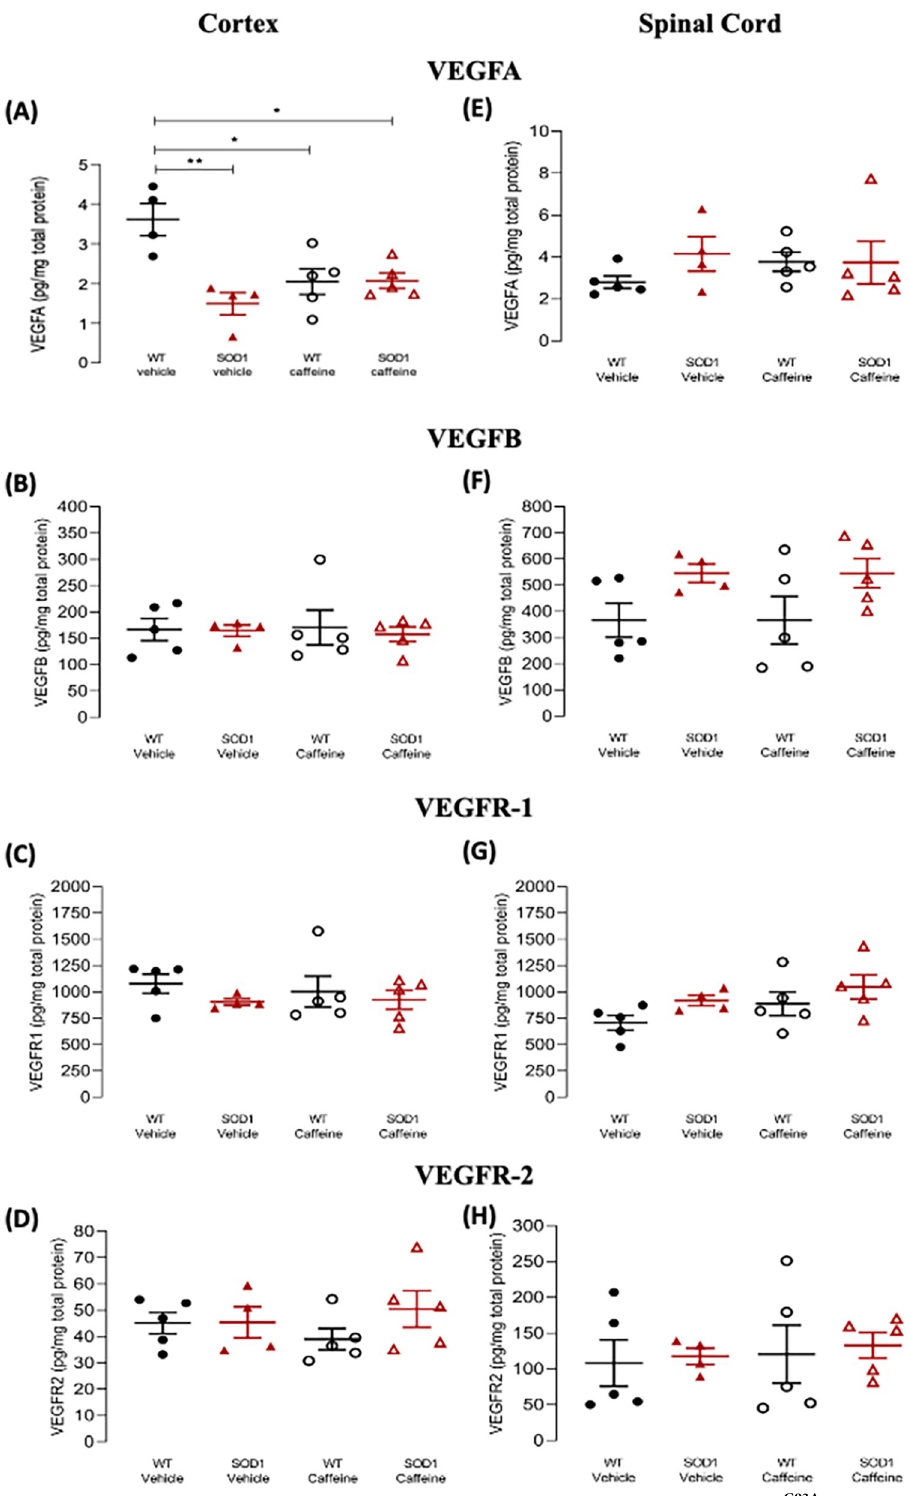
Fig 5. VEGF and VEGF receptor protein levels in the cortex and spinal cord of late stage SOD1 G93A and WT mice treated/non-treated with caffeine. (A- D) Data from cortical samples; (E-H) Data from spinal cord samples.